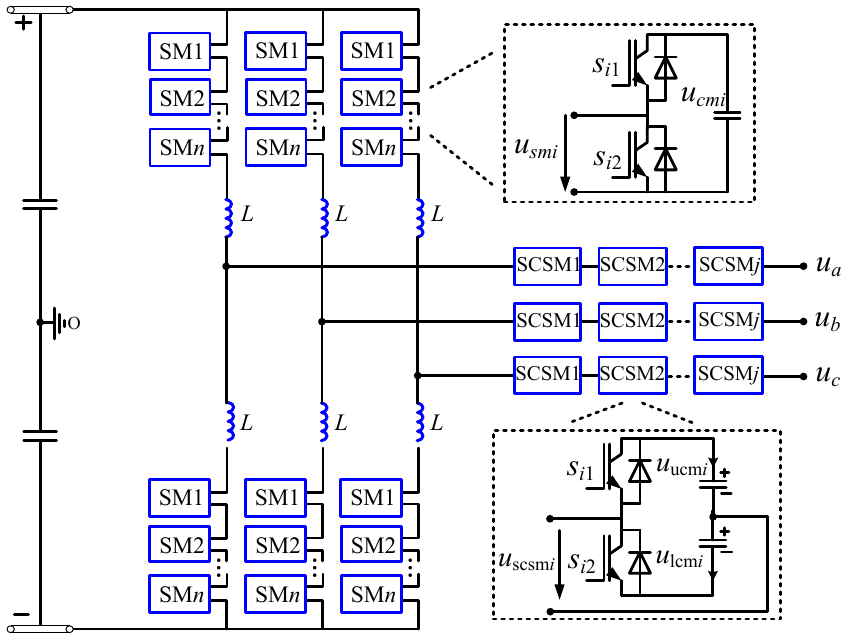
Figure 2. Schematic structure of the proposed hybrid MMC equipped with the SCSMs on the AC side.